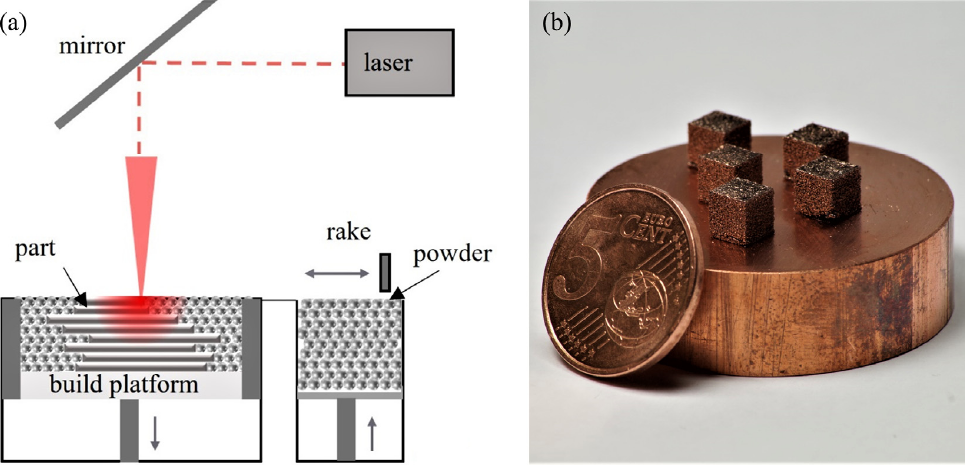
Figure 1. ( a ) Schematic depiction of the L-PBF machine setup. ( b ) Photograph of five printed